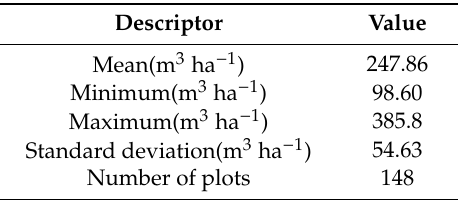
Table 1. Summary of descriptive statistics of